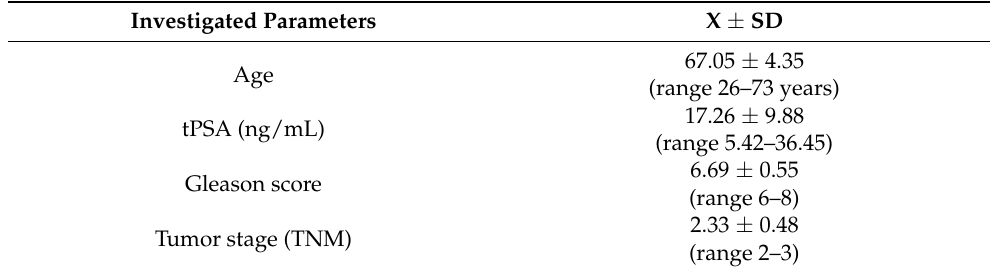
Table 1. The age and the level of PSA, Gleason score and tumor stage in investigated patients with PC. Investigated